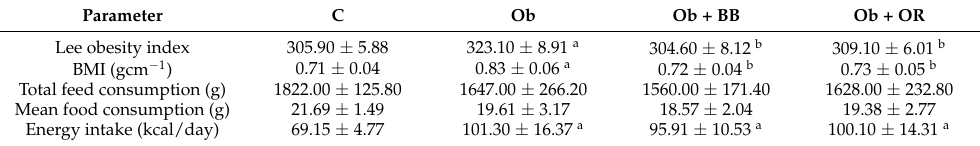
Table 3. Energy intake, feed consumption, Lee obesity index, and Body mass index in all groups.